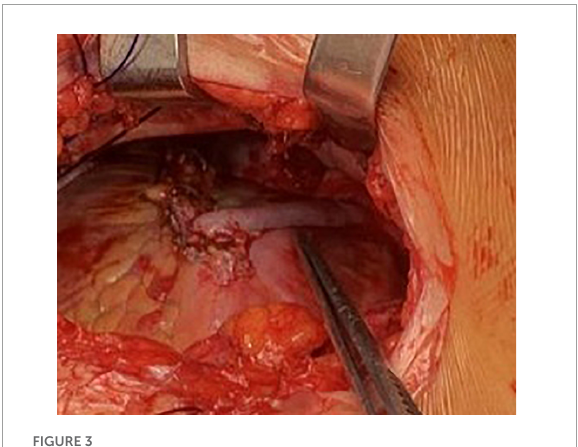
FIGURE3 Multivessel-MIDCAB, LIMA, to LAD and saphenous vein (T-graft) to diagonal branch anastomoses.